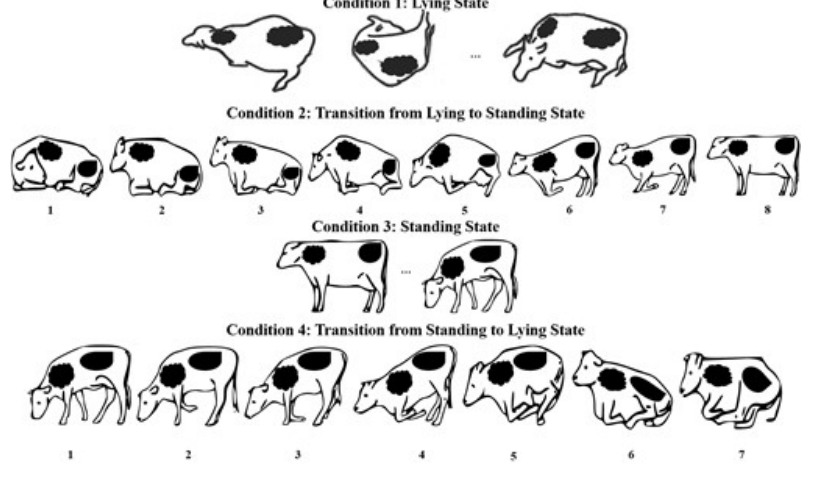
Figure 2. A sample of four posture conditions before calving.